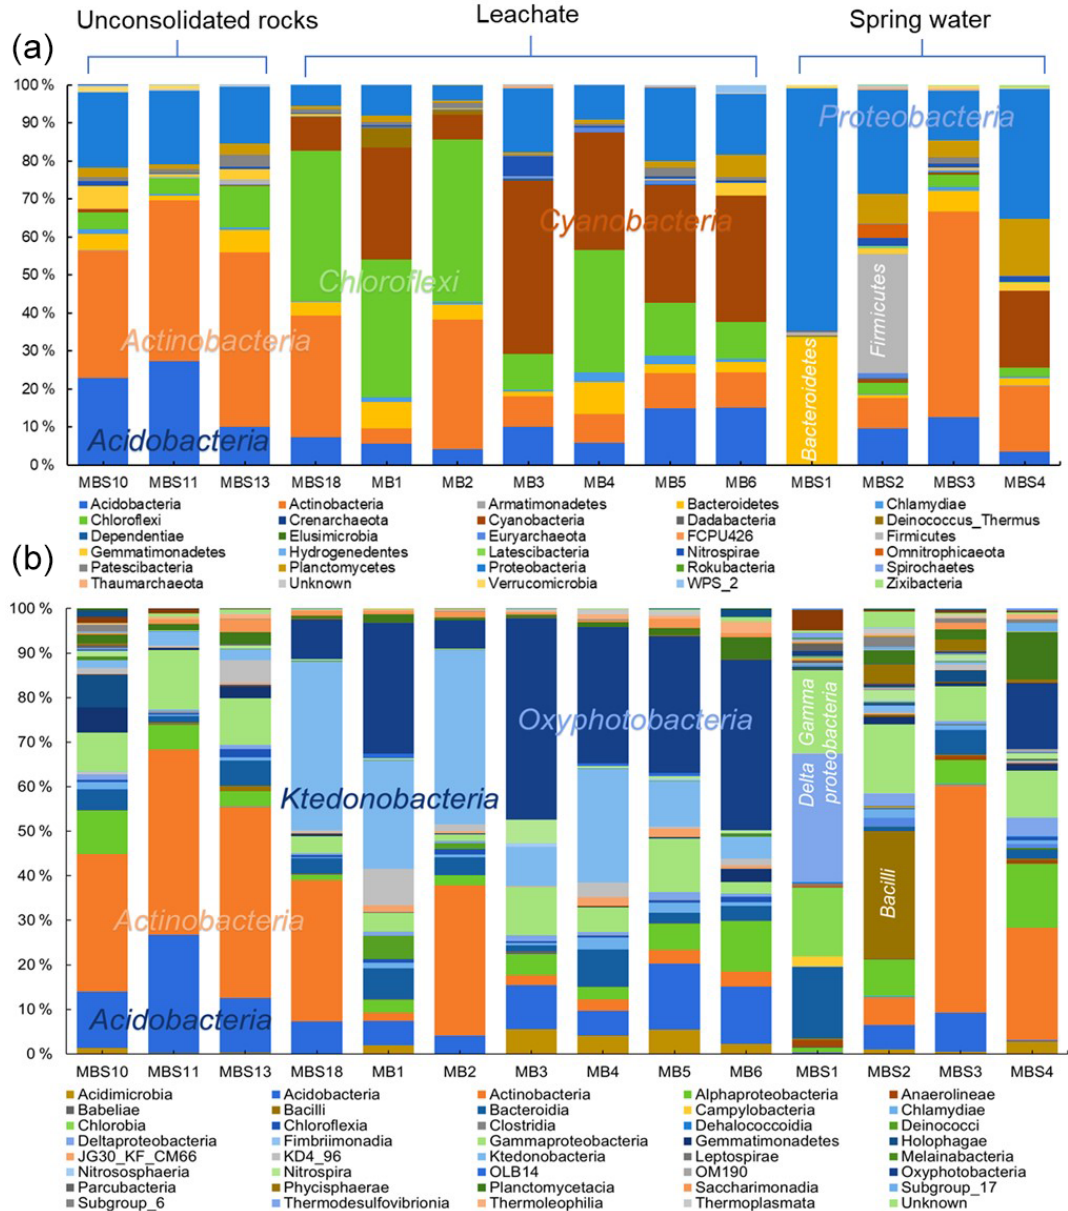
Figure 5. Relative abundances of Marsberg Kilianstollen bacterial taxa. At phylum (a) and class (b) level, the taxonomy and relative abun- dance of the OTUs depicts the bacterial community composition and colonization at Kilianstollen sampling sites. The samples are shown in three groups based on their origin (unconsolidated rocks, leachate, and spring water). The classes showing less than 2% relative abundance are not mentioned. Besides bacterial taxa, the selected primers also led to the detection of Crenarchaeota, Euryarchaeota, and Thaumar- chaeota in low abundance. The excel data sheets are accessible at https://data.goettingen-research-online.de/dataset.xhtml?persistentId=doi: 10.25625/DFFZ9R, last access: 4 May